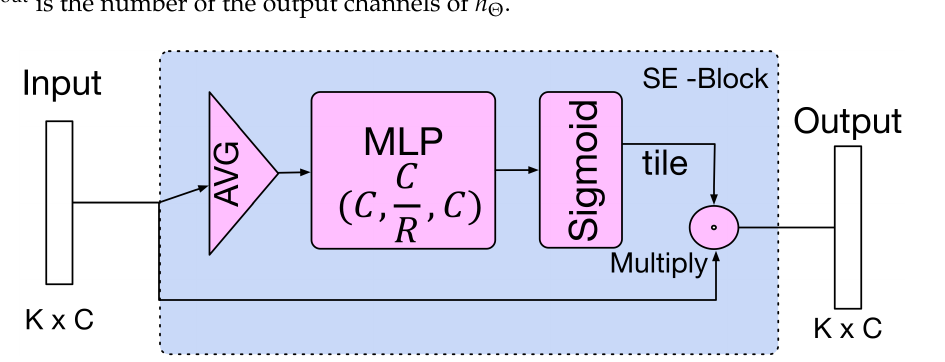
Figure 3. SE-Block